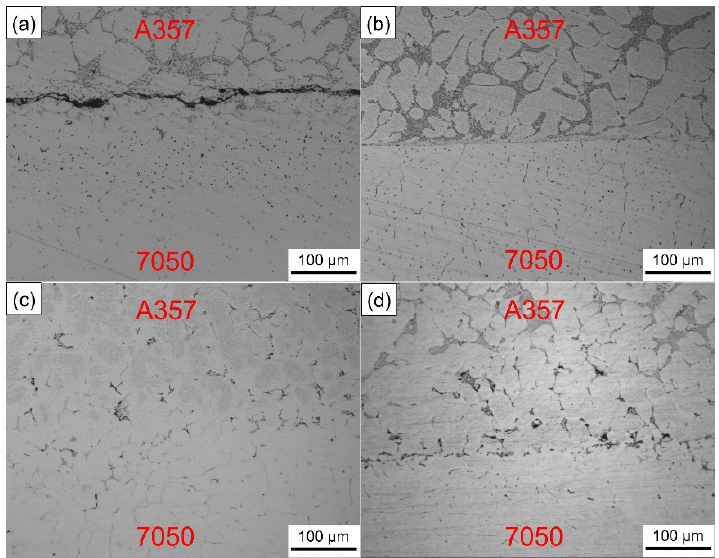
Figure 13. Interfacial metallographic structure of A357 ring and 7050 compound casting parts at different preheating temperatures: ( a ) 25 °C, ( b ) 100 °C, ( c ) 200 °C and ( d ) 300 °C.